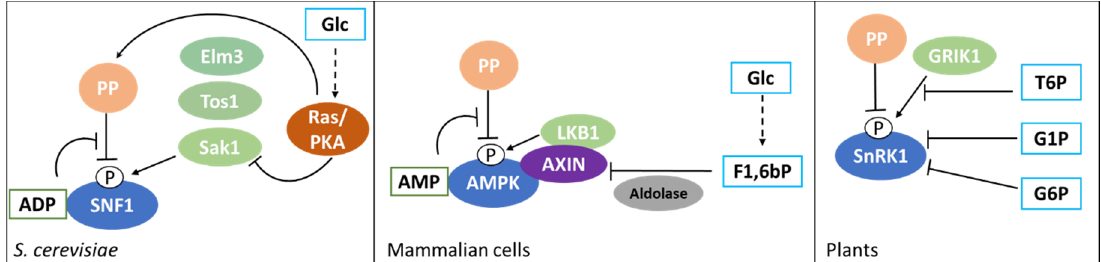
Figure 2. SNF1 / AMPK / SnRK1 modulation by nucleotides (green boxes) and glucose metabolites (light blue boxes) in di ff erent species. ADP and AMP inhibit dephosphorylation of the regulatory Thr, in yeast and in mammalian cells, respectively. Glucose metabolites inhibit phosphorylation, although the specific mechanism is di ff erent in the di ff erent species. Additionally, AMPK is also controlled by glycogen through its binding with the Carbon Binding Module (CBS). See text for details. Continuous arrows indicate direct activations, dashed lines indicate indirect processes.